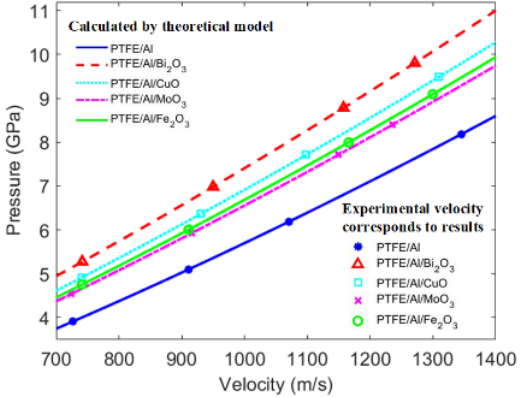
Figure 7. Pressure varying with impact velocity.